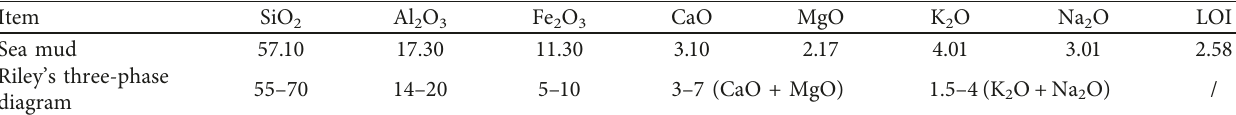
Table 2: Chemical composition (%) of DSM.